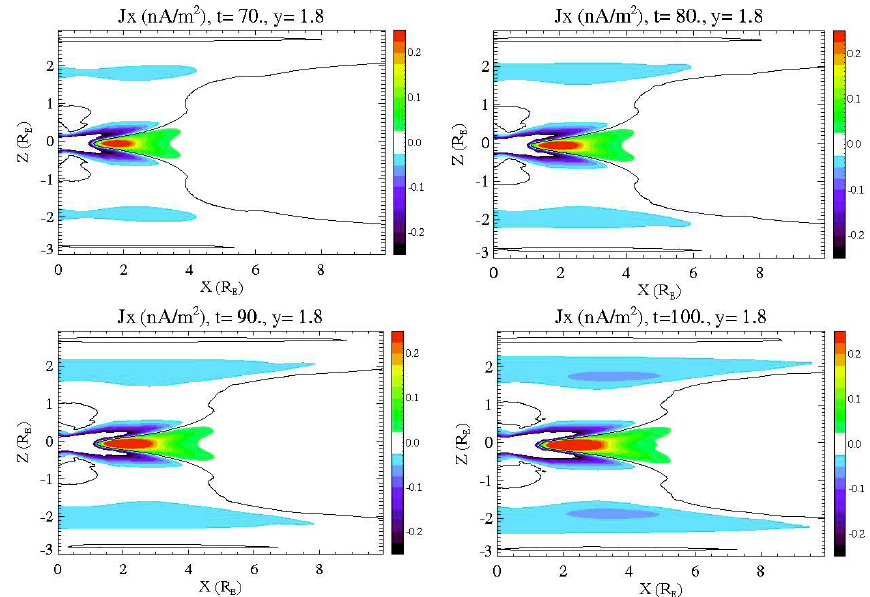
Fig. 4. Contours of the j x current at 70, 80, 90, and 100s into the run. Blue and black colors are negative (tailward) currents and green and red are positive (Earthward currents). The black contours give the zero current